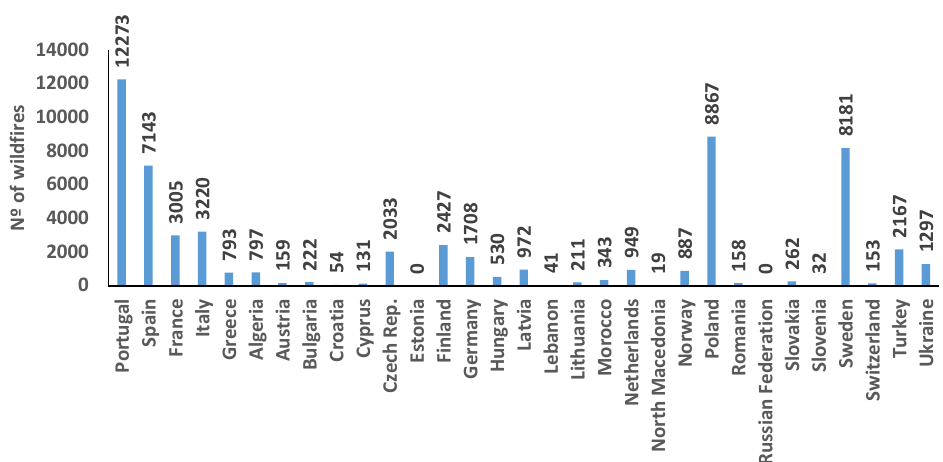
Figure 1. Number of wildfires in Europe, the Middle East, and North Africa in 2018.